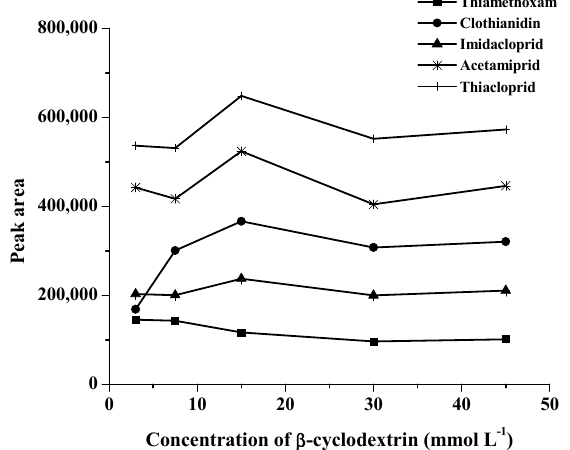
Figure 3. Effect of concentration of β -cyclodextrin on the extraction of studied neonicotinoids.